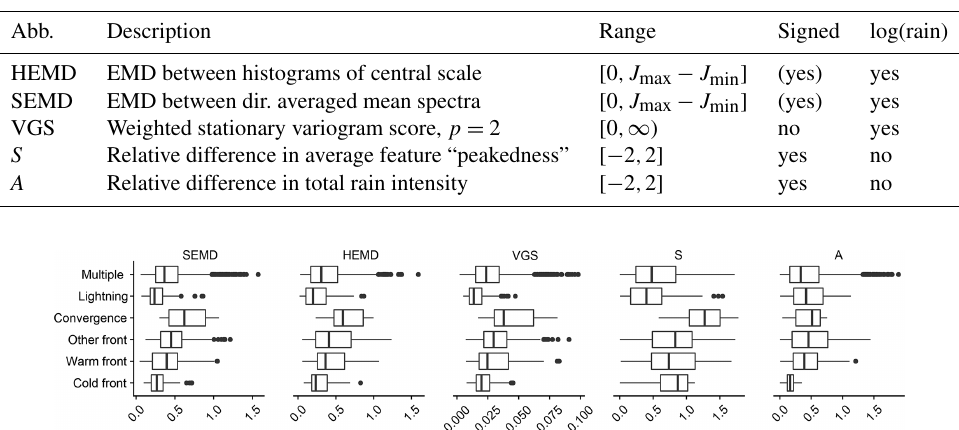
Table 2. All scores used in Sect. 7. J max and J min refer to the largest and smallest considered scale of the wavelet decomposition. In this study, J max − J min = 7 − 1 = 6. The optimal value of each score is zero.